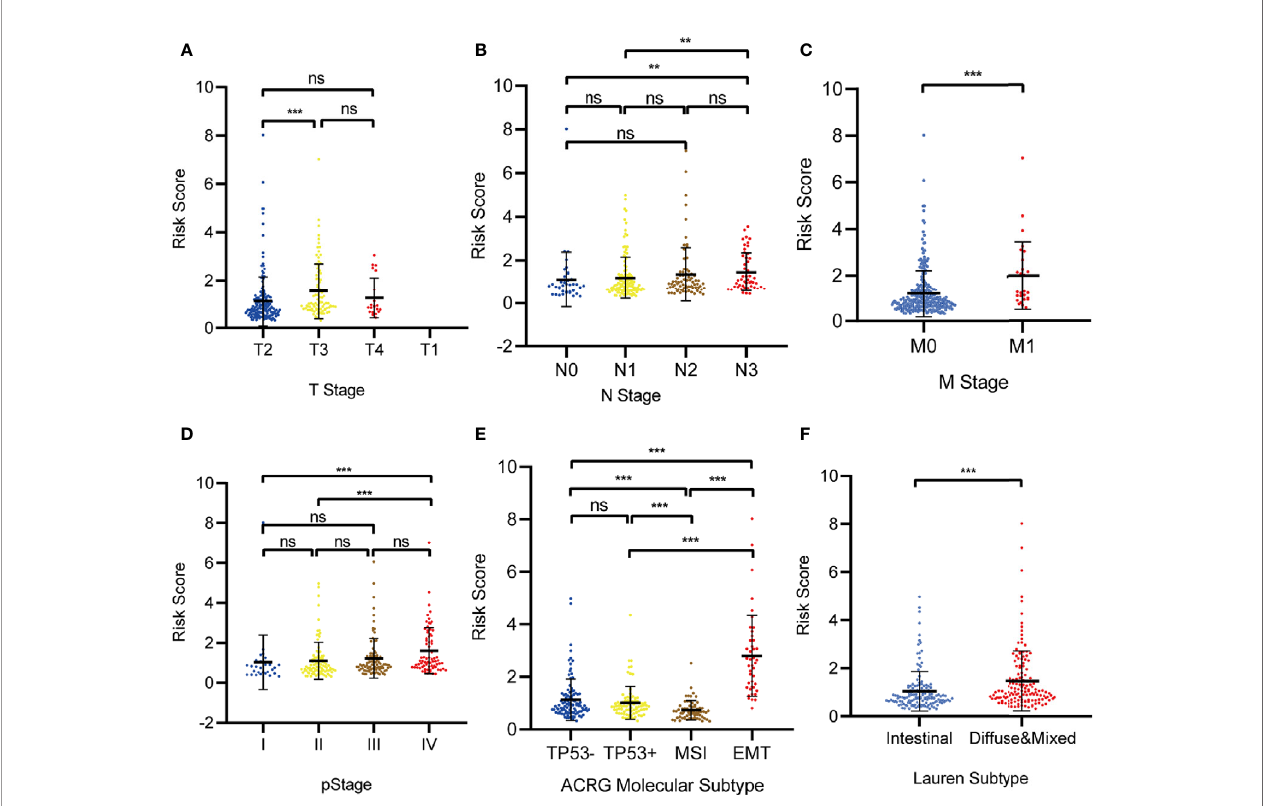
FIGURE 10 | The correlation between the Risk Score and (A) T stage; (B) N stage; (C) M stage; (D) pStage; (E) Asian Cancer Research Group (ACRG) molecular subtype; (F) Lauren subtype. (*p < 0.05, **p < 0.01, ***p < 0.001, ns, no signi fi